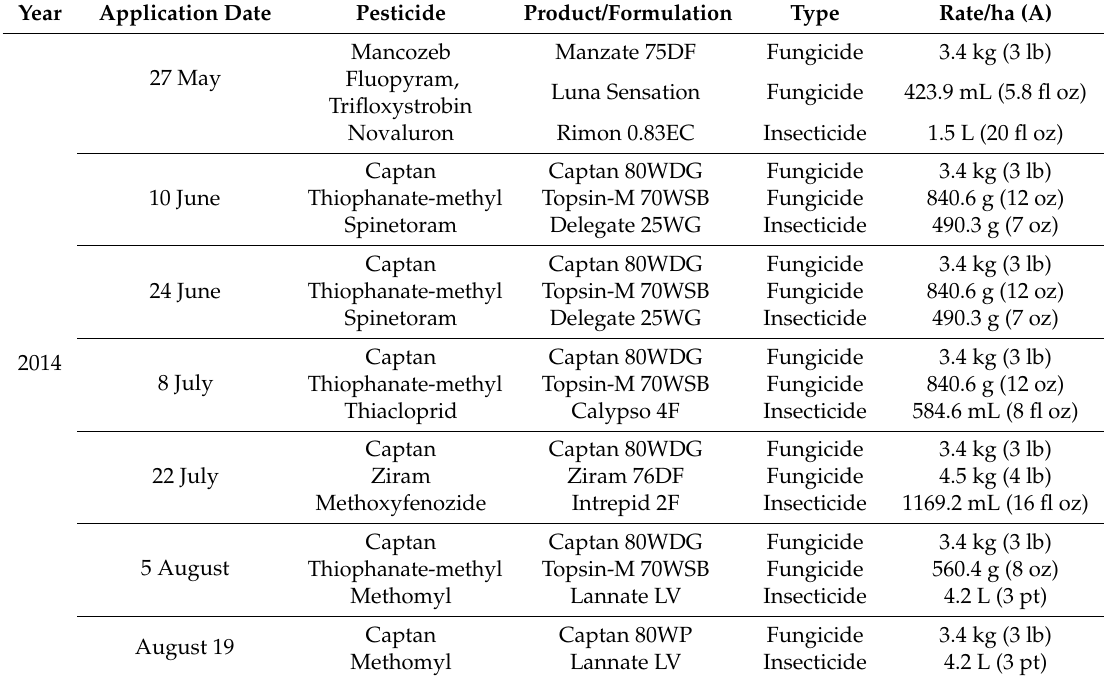
Table 2. Application date, pesticide, product/formulation, type, and application rate for the conventional pesticide management treatment in 2014 and